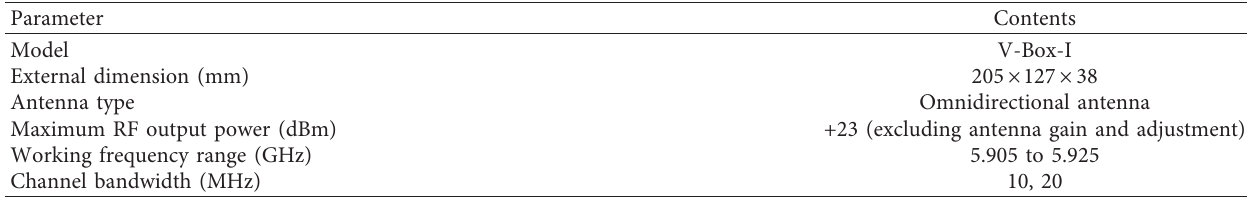
Table 2: Some OBU parameters for LTE-V.